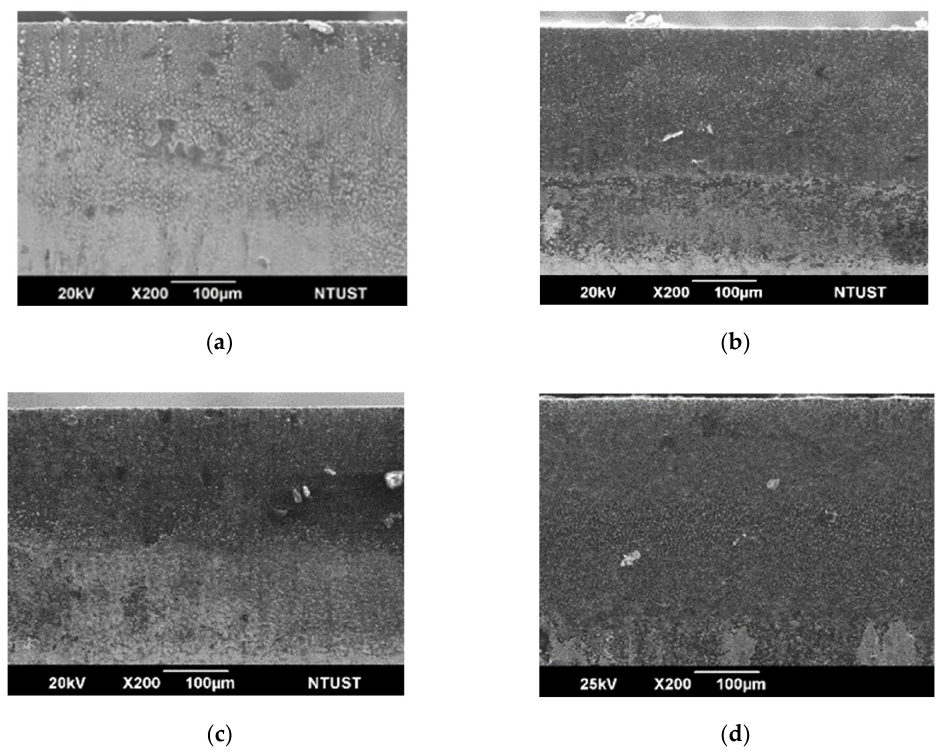
Figure 14. SEM morphologies of the laser finished surface (laser finishing parameters are average power of 30 W, scan rate of 5 mm/s, pulse width of 50 ns, repetition rate of 90 kHz). ( a ) The surface without laser finishing; ( b ) the surface after laser finishing using Method 1; ( c) the surface after laser finishing using Method 2; ( d ) the surface after laser finishing using Method 3.